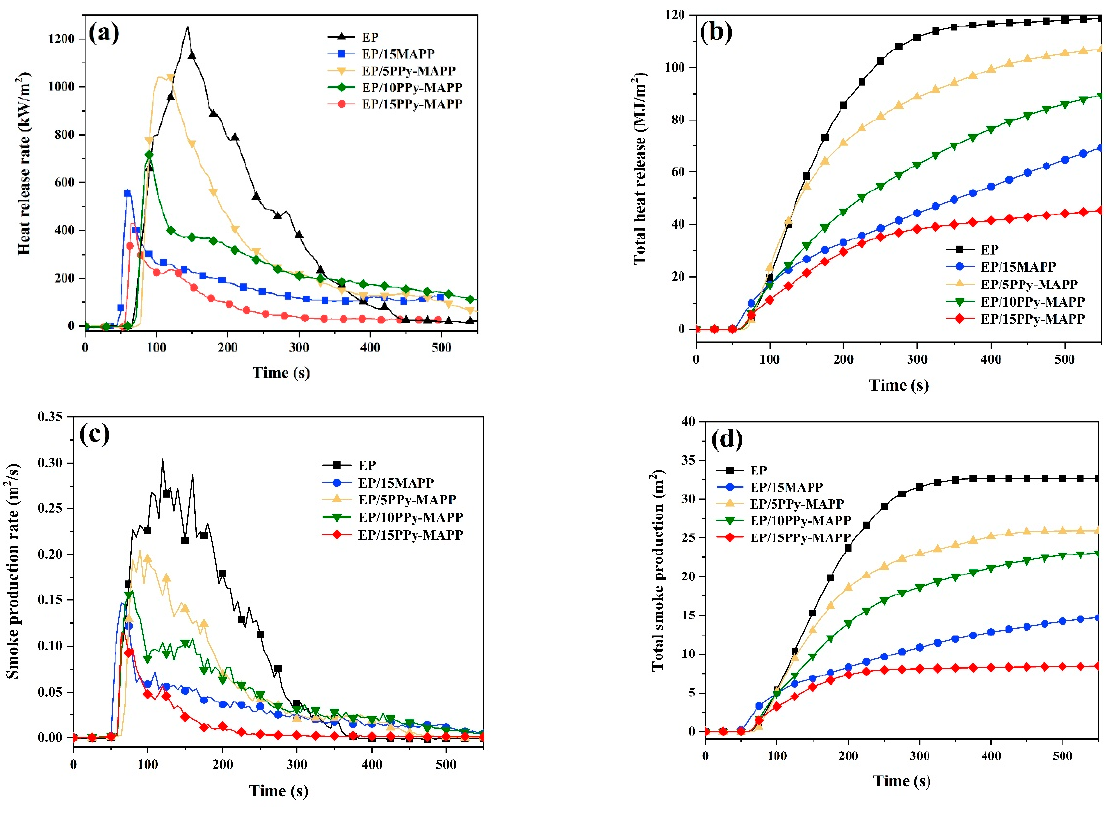
Figure 8. Cone calorimeter data of epoxy composites: heat release rate ( a ), total heat release ( b ), smoke production rate ( c ) and total smoke production ( d ).